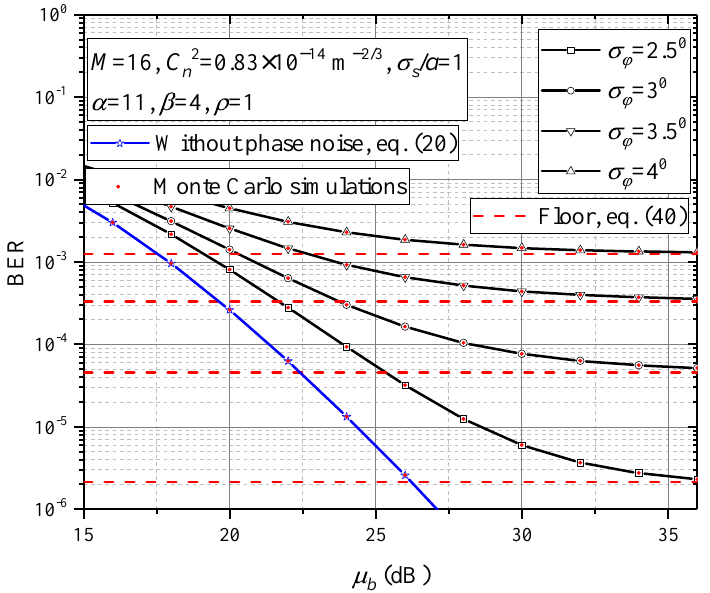
Figure 3. Average BER vs. average SNR per